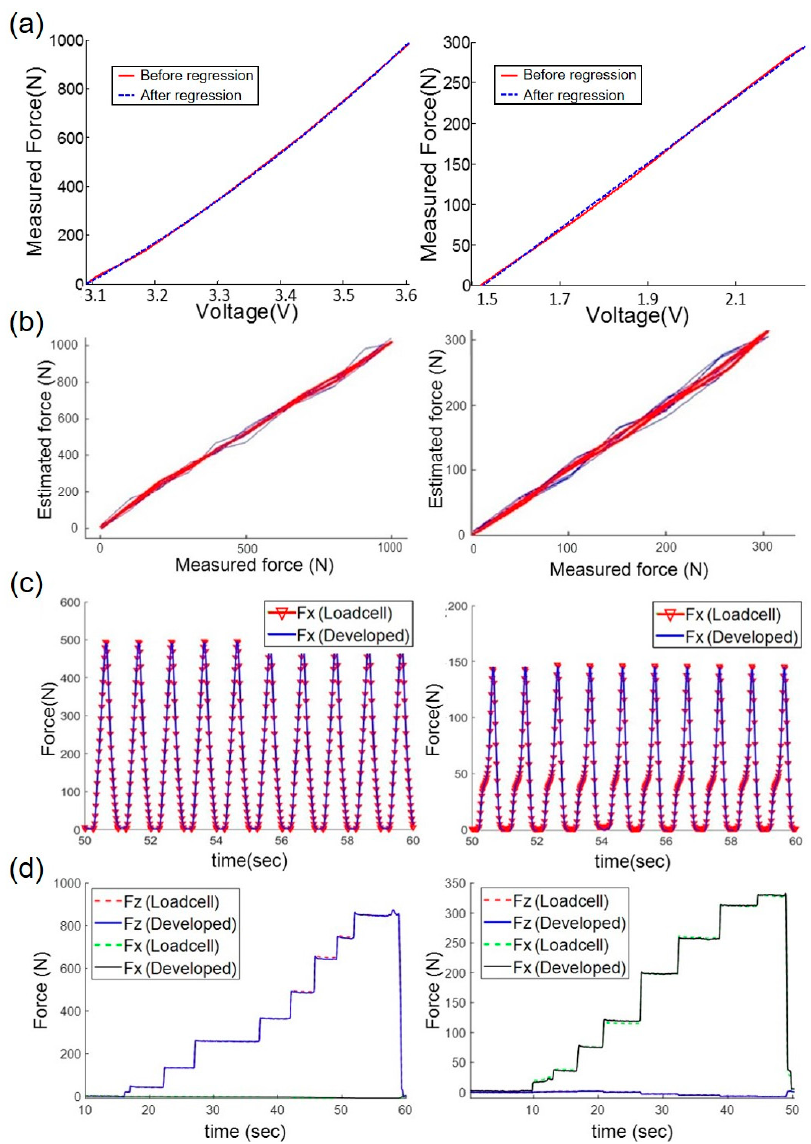
Figure 6. Sensor characterizations. ( a ) Calibration results of the developed force sensor for the normal (left) and shear direction (right). ( b ) Hysteresis of the developed force sensor with the load cell for the normal (left) and shear direction (right). ( c ) Response of the developed force sensor with a repeated load for the normal (left) and shear directions (right). ( d ) Response of the developed force sensor for the normal direction when the shear force is loaded (left) and for the shear direction when the normal force is loaded (right).